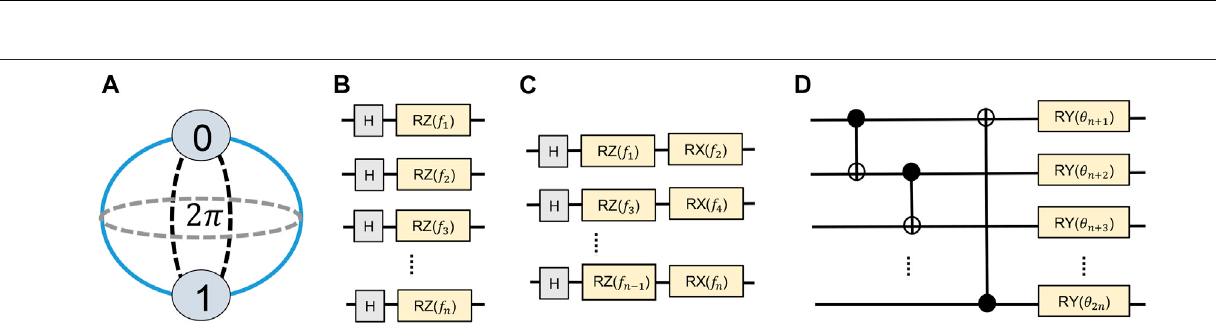
FIGURE 1 | Conventional quantum neural network (QNN) and the proposed architecture (QNet). Each conventional QNN consists of a classical-to-quantum data encoding circuit followed by a parametric quantum circuit and measurement operations. QNet consists of several conventional QNN ’ s placed in different QNN layers. Each QNN layer is followed by classical non-linear activation and random shuf fl ing of the output vector.